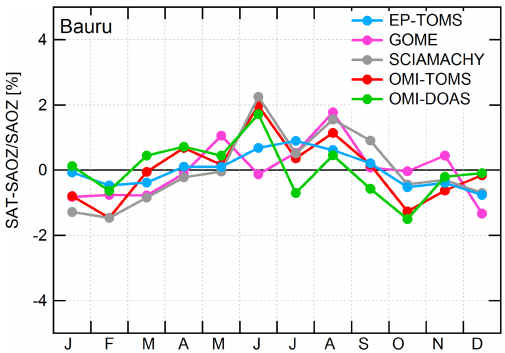
Figure 4. Relative difference of the seasonal ozone cycle between satellite and ground based observations at Bauru. GOME GDP5 (pink), EP-TOMS (blue), SCIAMACHY OL3 (grey), OMI-TOMS (red), OMI-DOAS